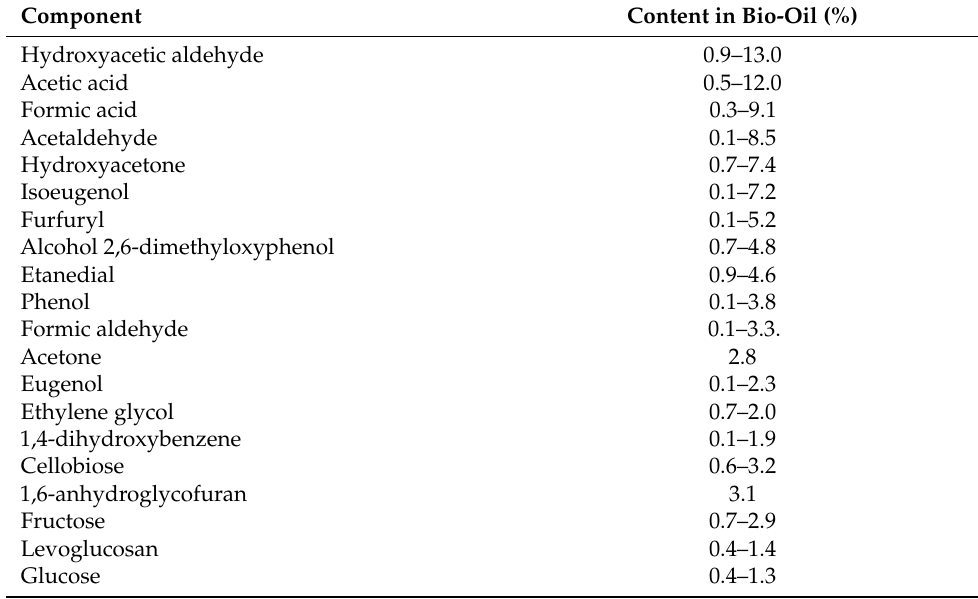
Table 2. List of chemical compounds occurring in the highest amounts in bio-oil from rapid pyrolysis (own elaboration from